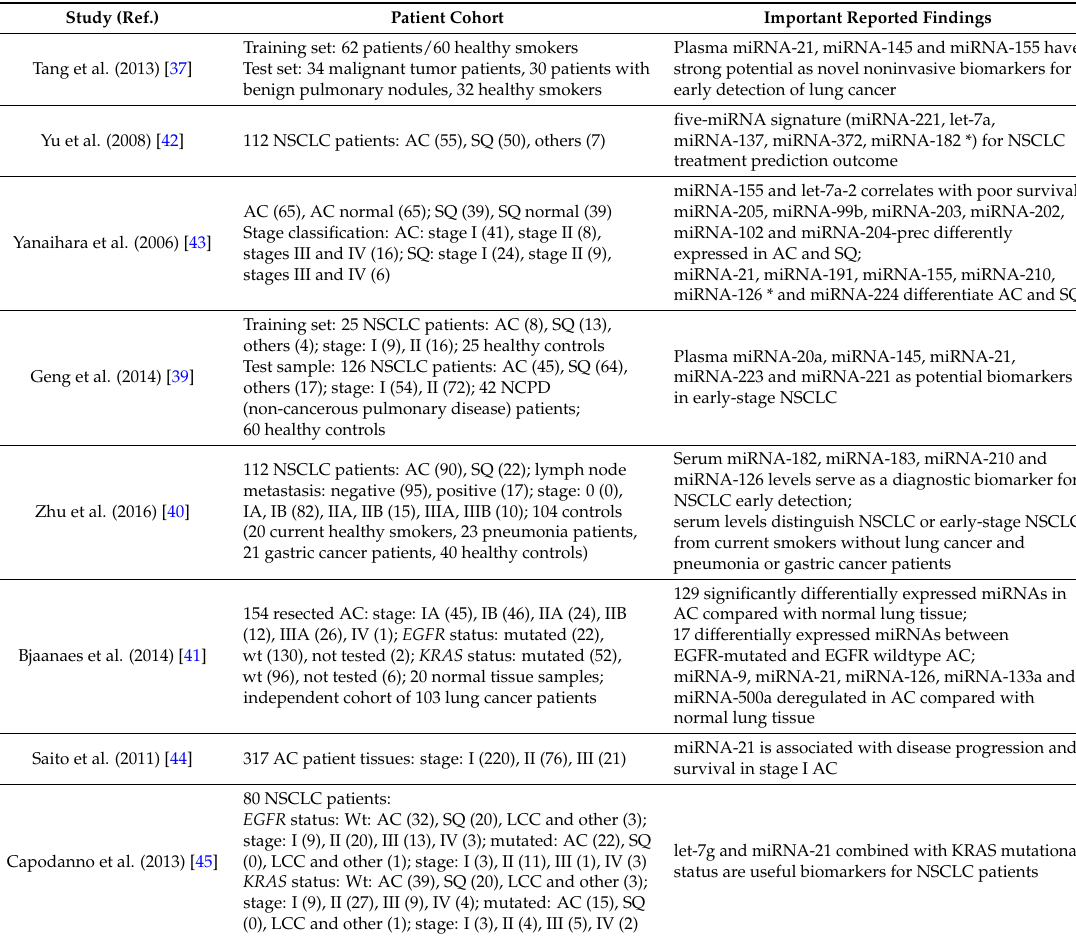
Table 1. Table summarizing the different lung cancer miRNA studies.